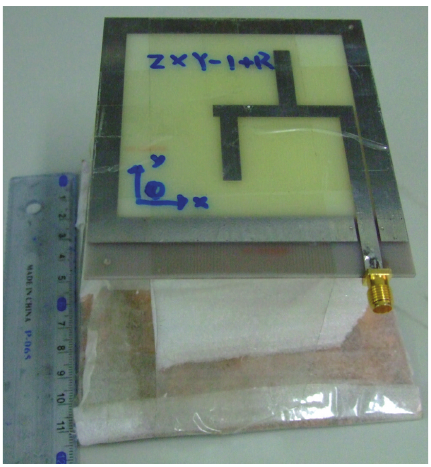
Figure 15: Prototype of antenna with reflecting plate.